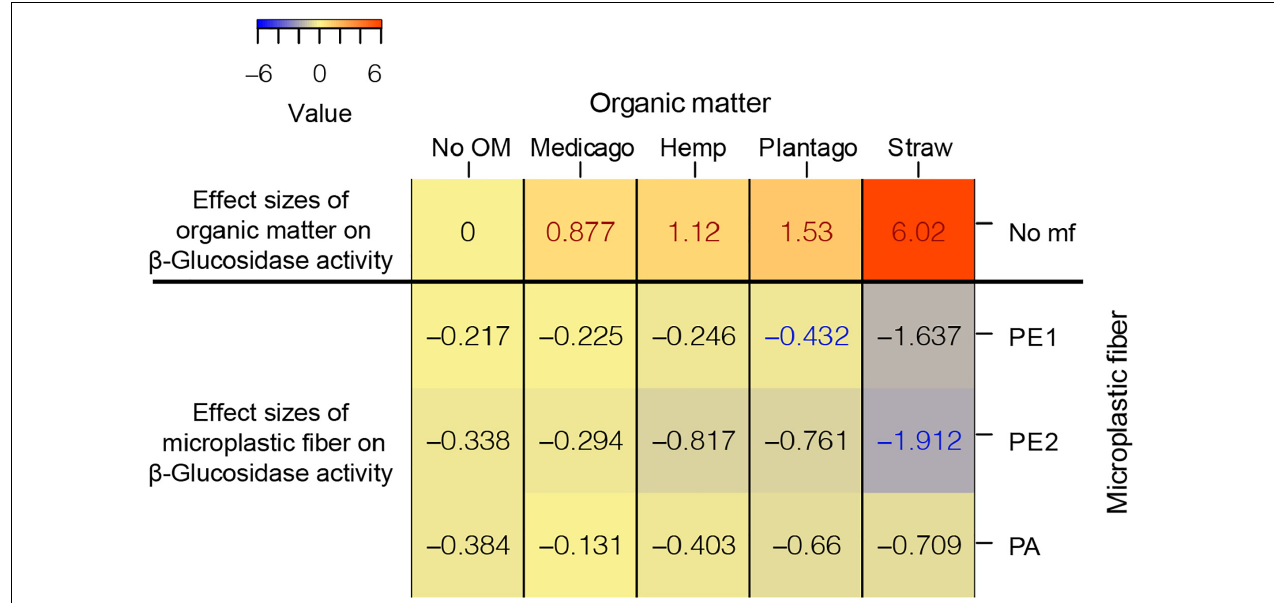
FIGURE 4 | The heatmap of the effect sizes of microplastic fiber and organic matter on β -Glucosidase activity. The effect sizes of organic matter on β -Glucosidase activity were the unpaired mean differences of organic matter addition alone and control ( β -Glucosidase activity organic matter – β -Glucosidase activity No OM ). The effect sizes of microplastic fiber are the unpaired mean differences of the microplastic fiber addition and control with the addition of the different types of organic matter ( β -Glucosidase activity organic matter_microplastic fiber – β -Glucosidase activity organic matter_Nomf ). The blue text represents the statistically significant negative effect of microplastic fiber on β -Glucosidase activity, the red text represents the statistically significant positive effect on β -Glucosidase activity. “No OM” represents no organic matter addition, “No mf” represents no microplastic fiber